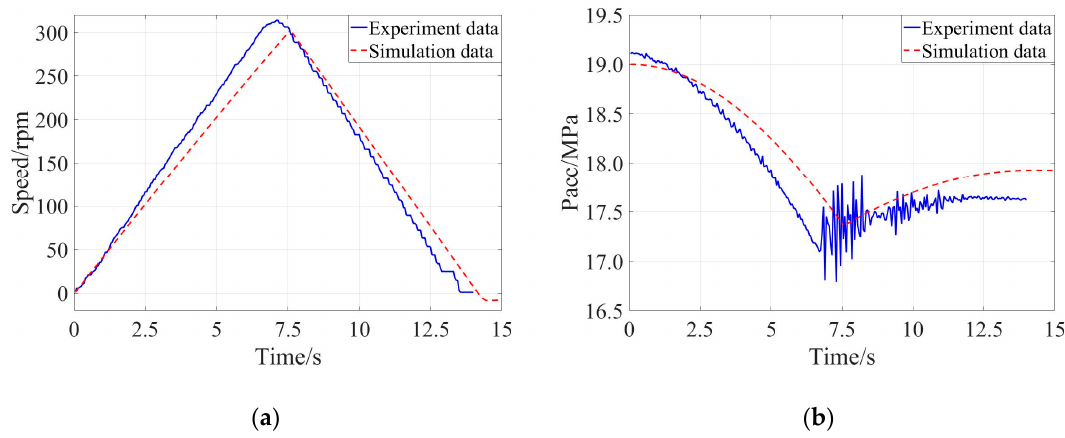
Figure 12. Comparison of the experimental result and simulation result when the braking intensity was 0.45: ( a ) Evolution of speed of the flywheel, ( b ) Evolution of pressure of the accumulator.